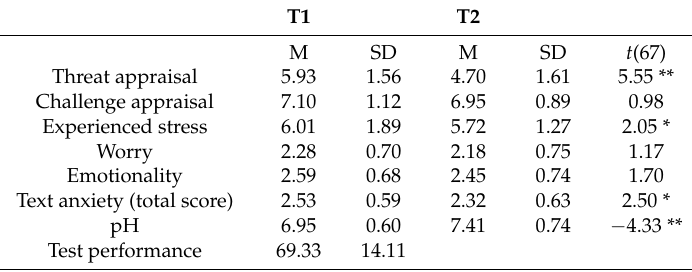
Table 4. Means (SDs) and range of study variables for Time 1 (T1) and Time 2 (T2). Used with permission from [59]